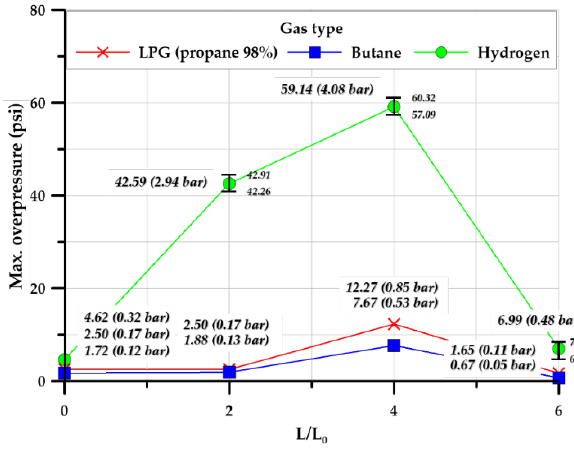
Figure 9. Maximum overpressure inside the cylinder-type chamber.